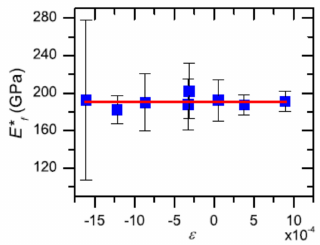
Figure 11. A–SiNxHy thin film E* f vs. ε calculated using A AFM . The solid line in each plot denotes the average value of the data